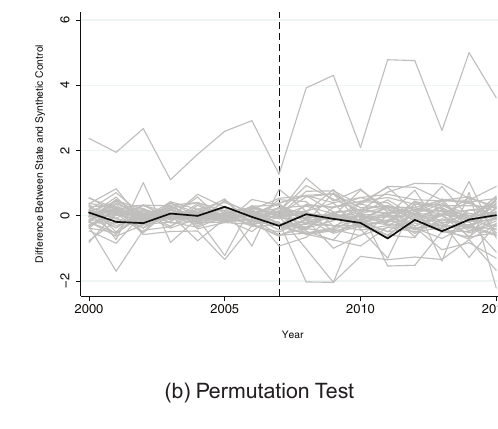
Native married women weekly hours (hours >